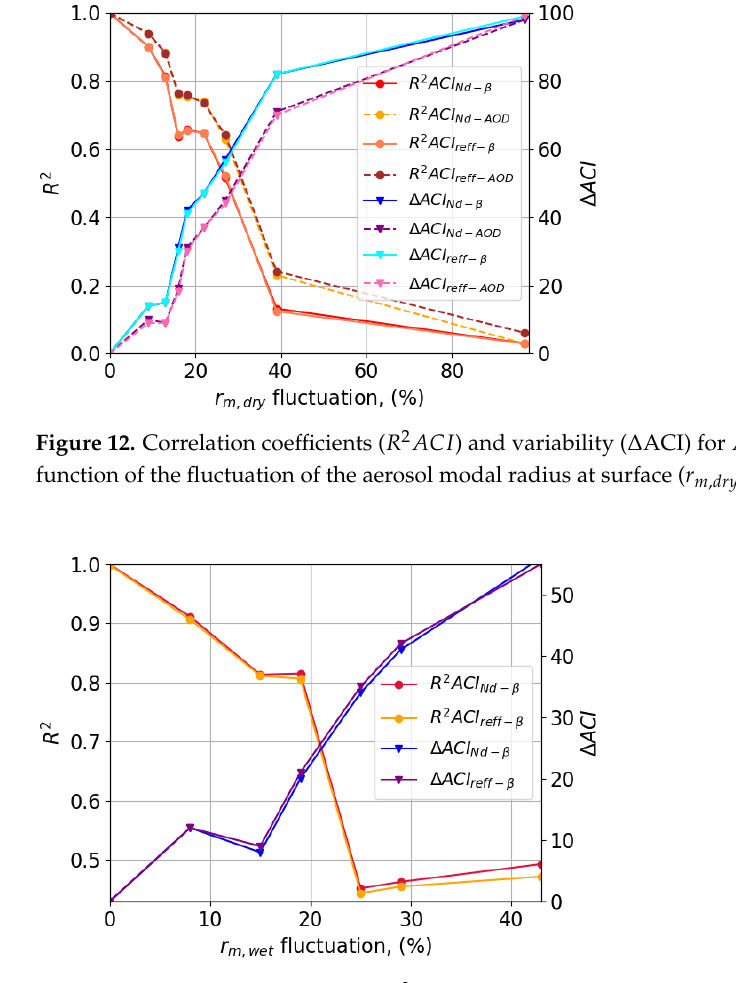
Figure 13. Correlation coefficients ( R 2 ACI ) and variability ( ∆ ACI) for ACI Nd − β and ACI ref f − β as a function of the fluctuation of the aerosol modal radius at the CBH ( r m , wet ) using